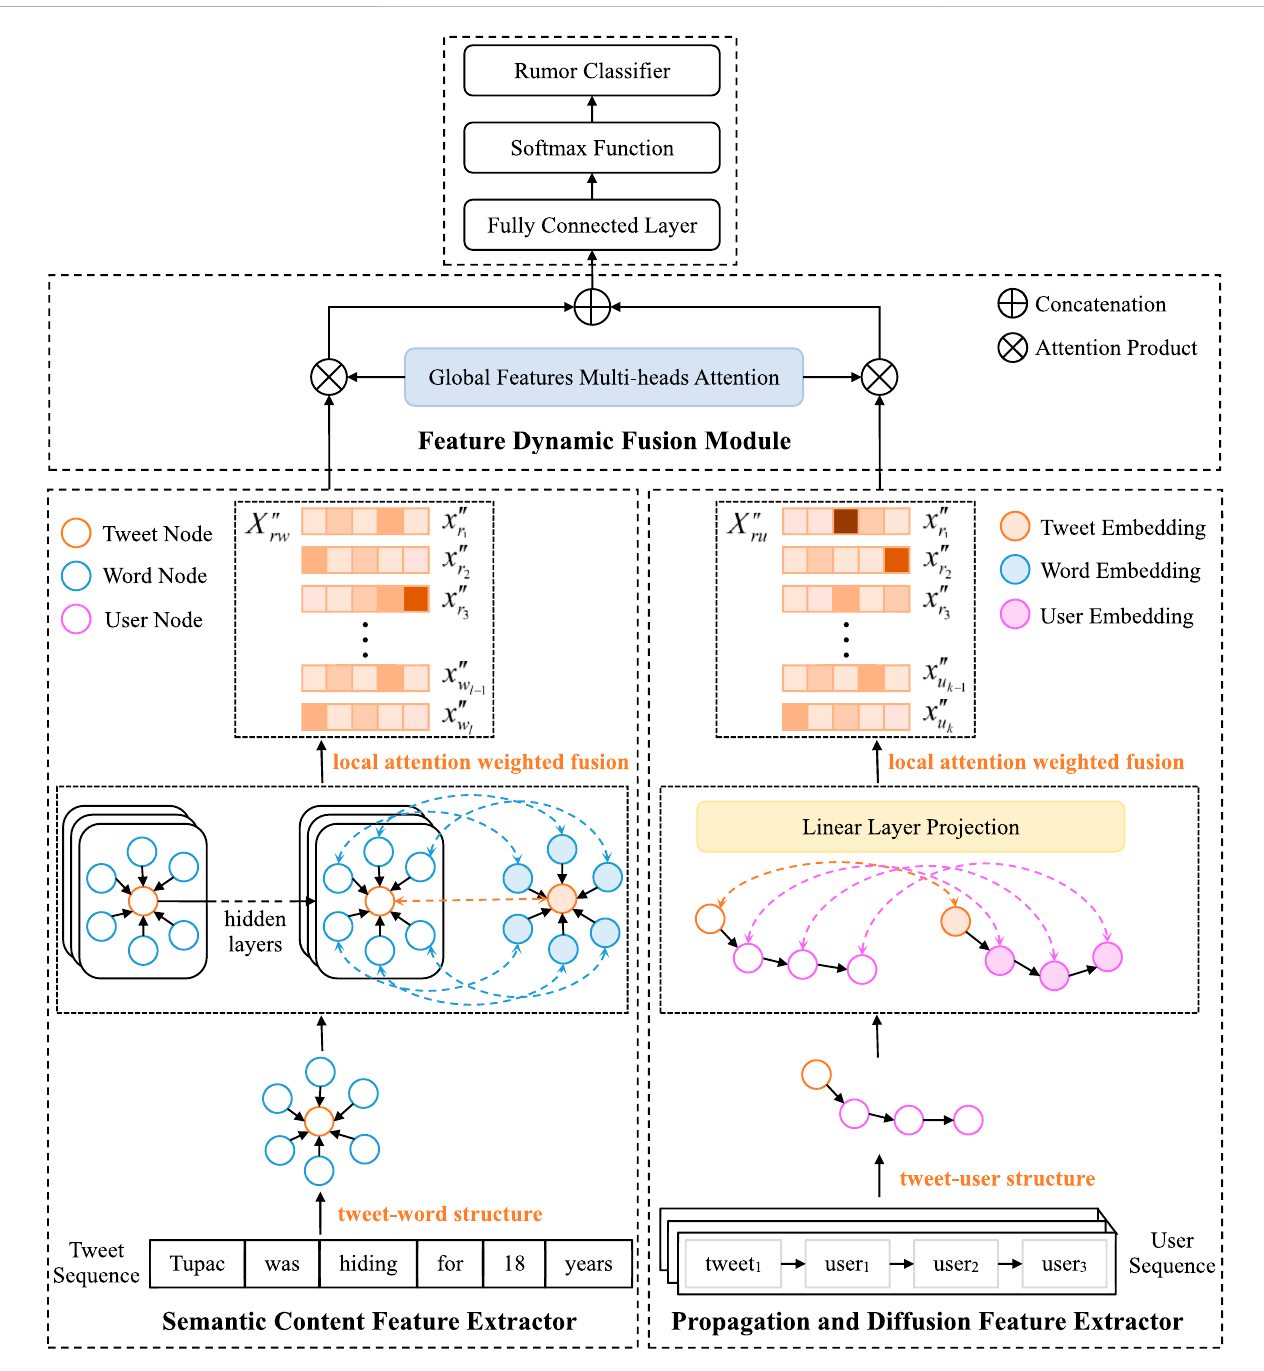
FIGURE 2 The architecture of the local-global attention model MSLG for rumor